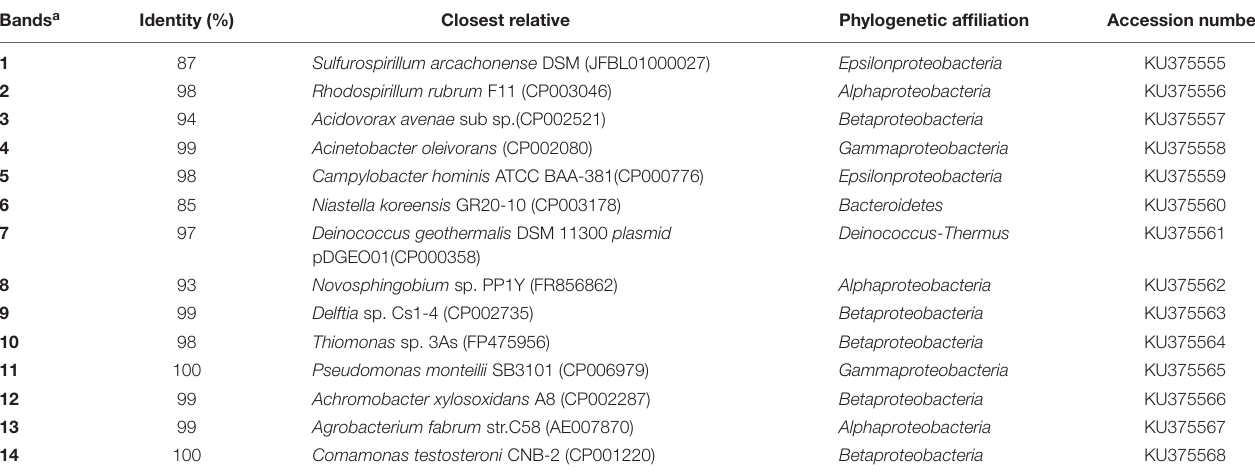
a The band labels correspond to those from the DGGE gels shown in Figure 2 .